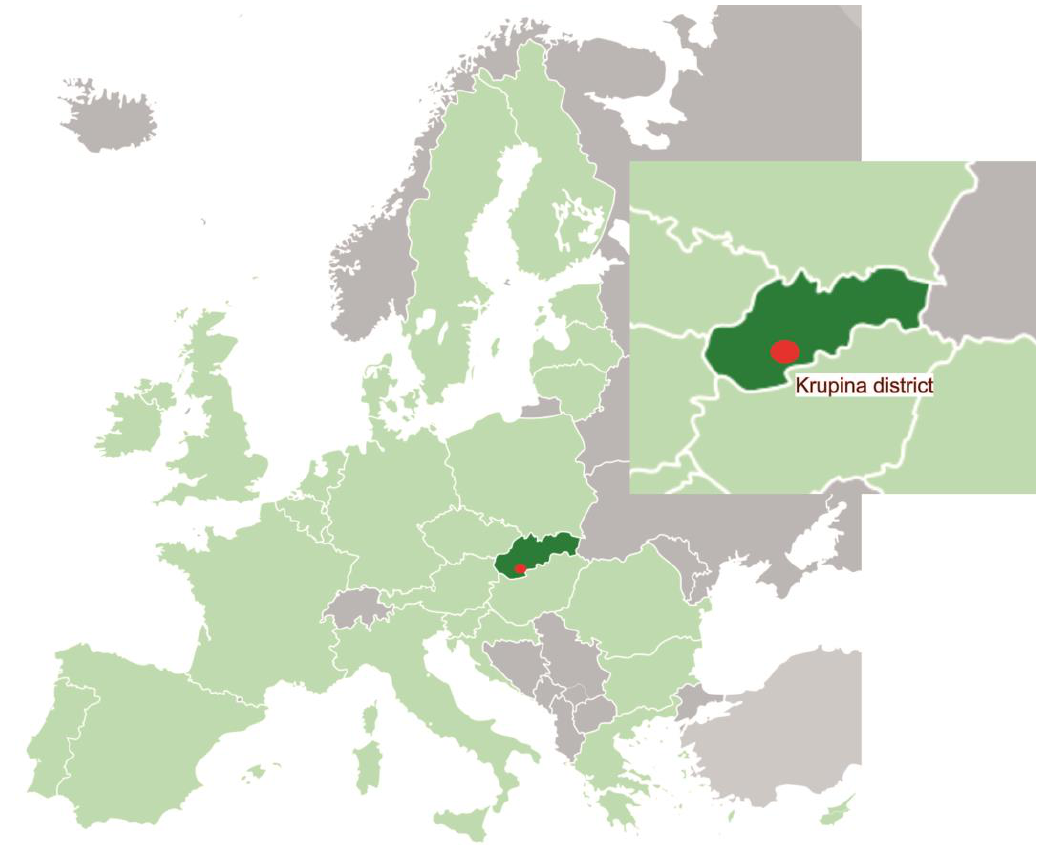
Figure 1. Schematic map showing the location of the study area in the Slovak Republic.